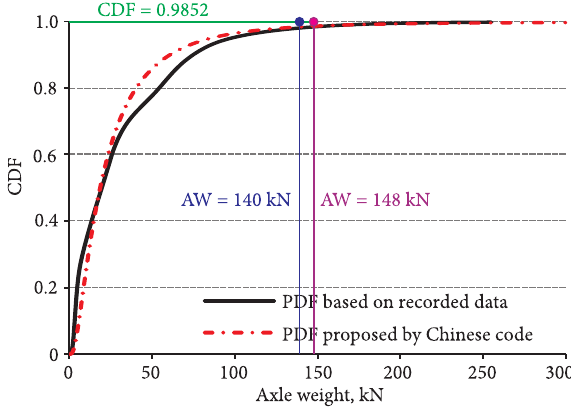
Fig. 10. PDF comparison of axle weight Fig. 11. CDF comparison of axle